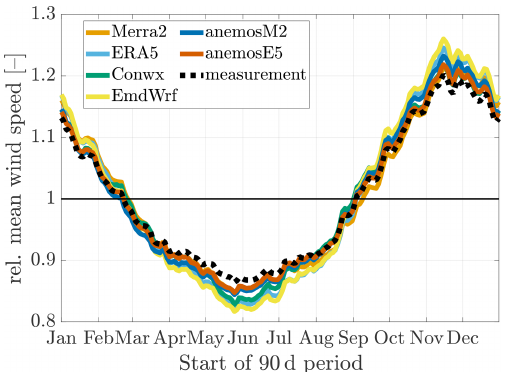
Figure 3. Deviation between reanalysis and measurement data in (normalized) mean wind speed (period of 90d, arithmetically aver- aged over all